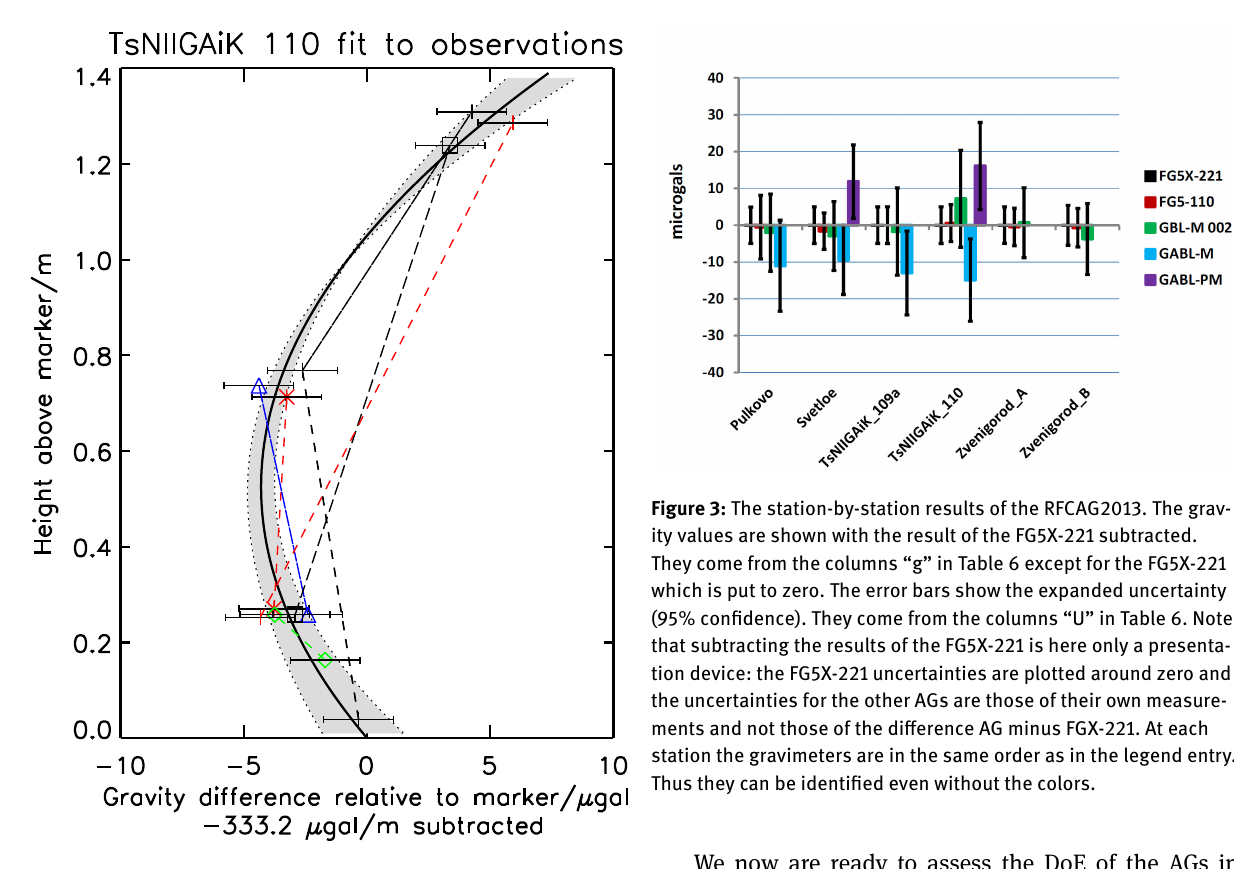
Figure 2: Relative measurements of gravity differences (the chords) and the fitted second-degree polynomial (the solid curve) above the station marker at the station TsNIIGAiK 110. Height above the marker is on the vertical axis and gravity is on the horizontal axis. To make the deviation from linearity better visible a mean vertical trend of –333.2 µGal/m has been subtracted from observations and from the fitted polynomial before plotting. The error bars show √ the estimated standard uncertainty of 2 µGal for gravity values (i.e., 2 µGal for gravity differences). This uncertainty is used in the polynomial fit, instead of the standard deviation derived from the elimination of drift in the relative observation series. The latter figure would typically be much smaller and is considered unrealis- tic. Shading shows the standard uncertainty of the gravity differ- ence determined from the fitted polynomial relative to the height 1.000 m, where the absolute-gravity values are compared. The nu- merical values are in Table 4.